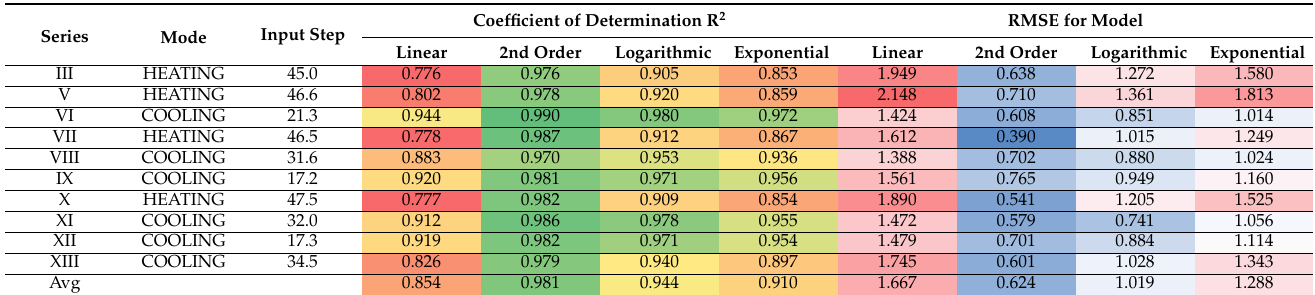
Table 1. Calculated coefficients of determination R 2 and RMSE of model fit.